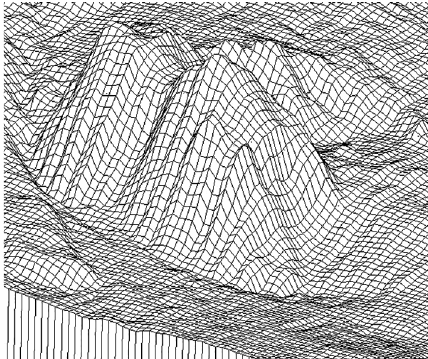
Figure 11. A wire frame view of the volcano area DEM St.